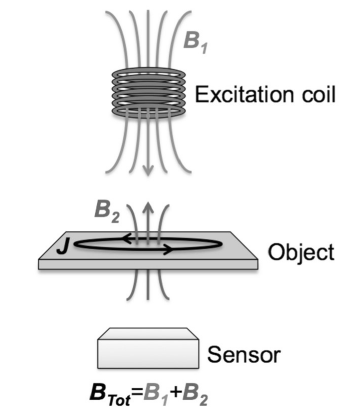
Figure 1. Principles of electromagnetic induction